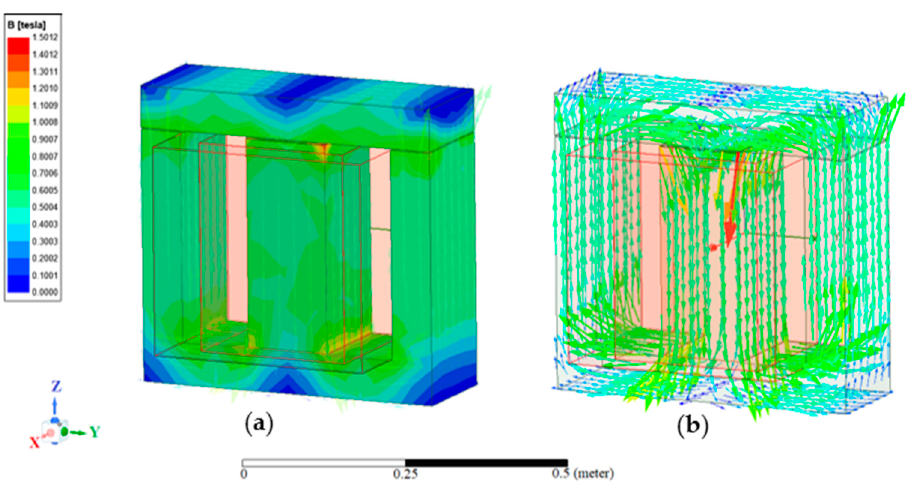
Figure 3. The flux density on the surface of the conventional transformer’s core ( a ) and its flux density vector representation ( b ).